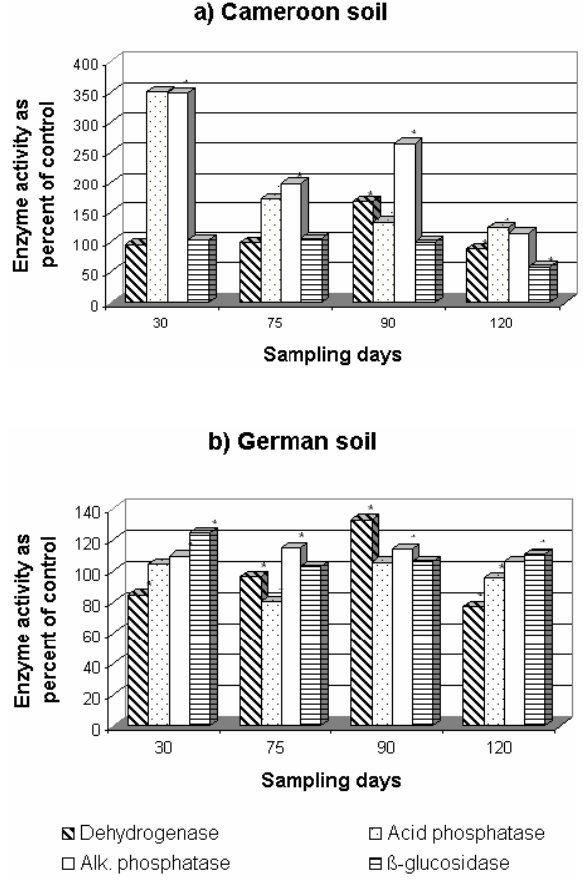
Figure 7 : Effect of mefenoxam on enzyme activities on both soils in the Cameroonian (a) and German (b) soils. * P <0.05 between fungicide addition and no fungicide addition (paired Student t-test).